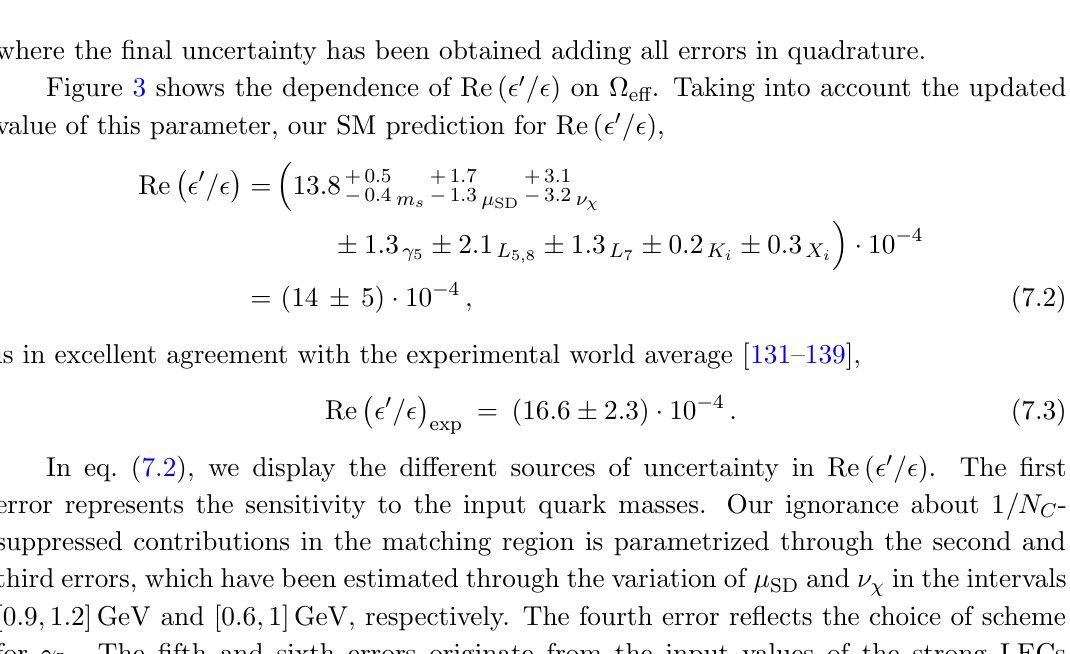
Figure 4 . SM prediction for Re ( (cid:15) 0 =(cid:15) ) (red dashed line) as a function of L 5 . The value of L 8 has been (cid:12)xed in terms of L 5 , using their relation in eq. (4.13). The red band has been obtained adding all sources of uncertainty in quadrature for a (cid:12)xed value of L 5 . The black dashed vertical lines represent the central value of L r ( M (cid:26) ) with its error, given in eq. (4.13). The blue horizontal band 5 is the measured value of Re ( (cid:15) 0 =(cid:15)